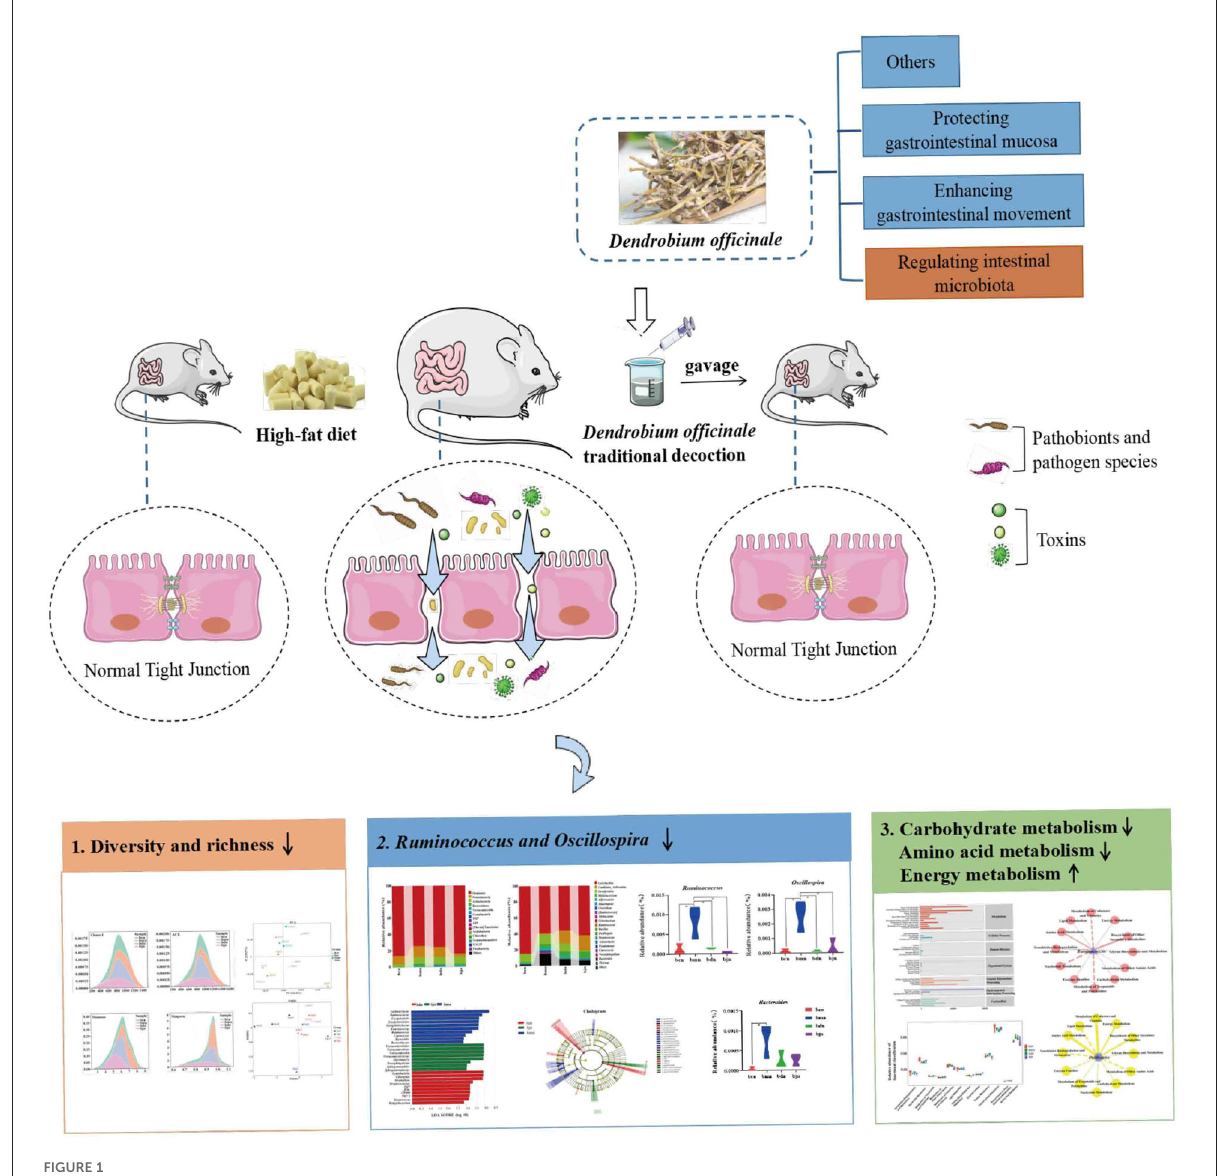
FIGURE1 Experimental flow